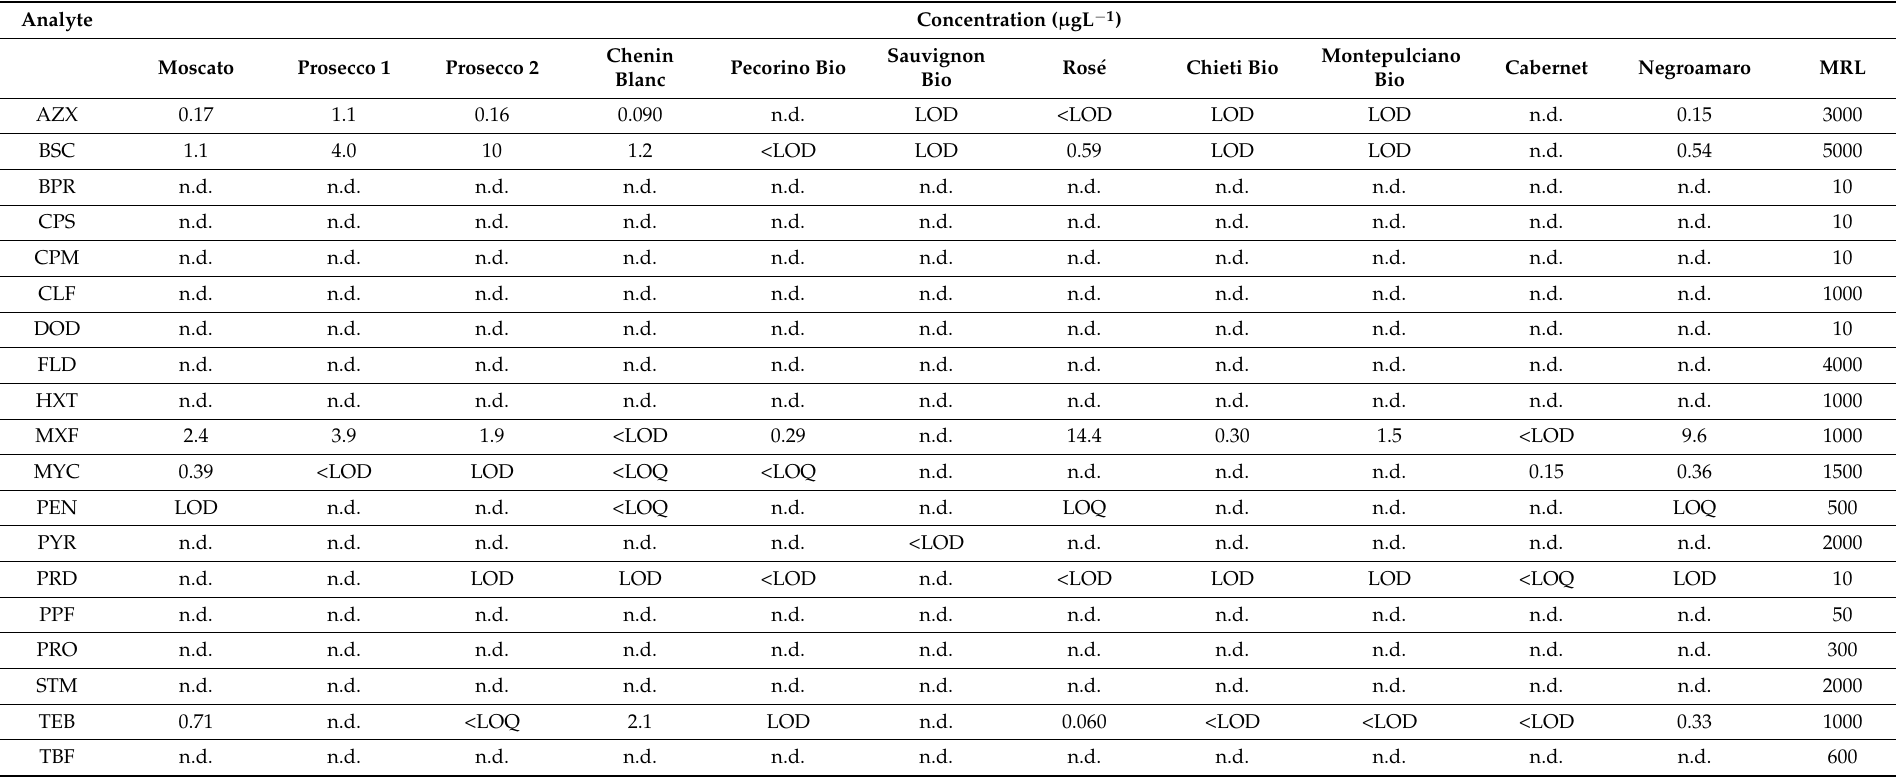
Table 4. Pesticide levels in commercial white (Moscato, Prosecco, Chenin Blanc, Pecorino, Sauvignon), ros é and red (Chieti, Montepulciano, Cabernet, Negroa- maro)